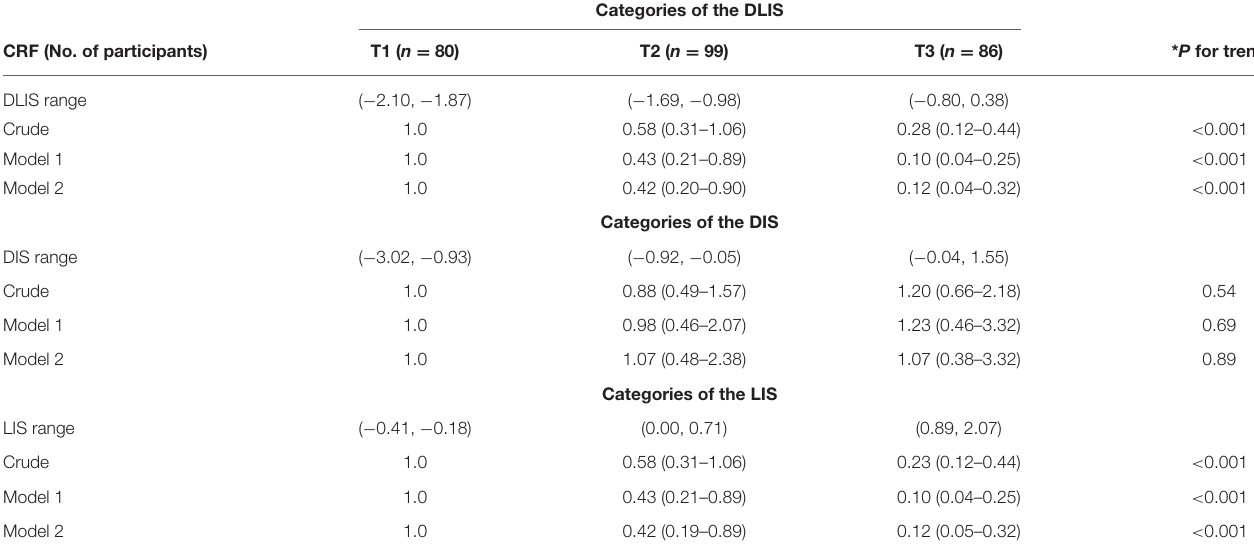
Categories of the